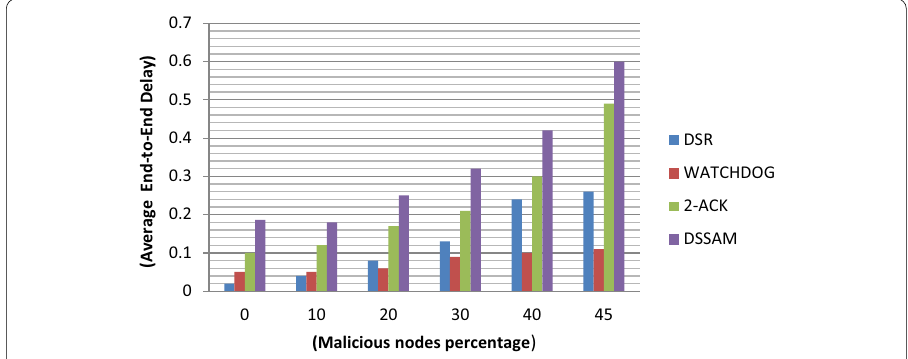
Fig. 13 Case 1-Average End-to-End Delay